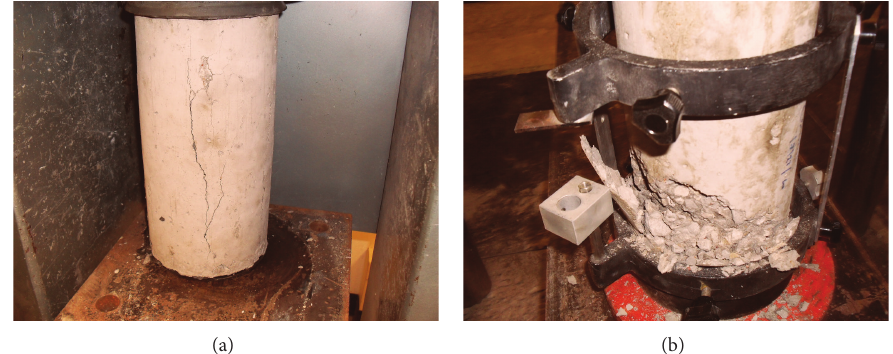
Figure 6: Control-0% TDA concrete failure patterns. The fracture line was generally parallel to the loading direction and failure was catastrophic.